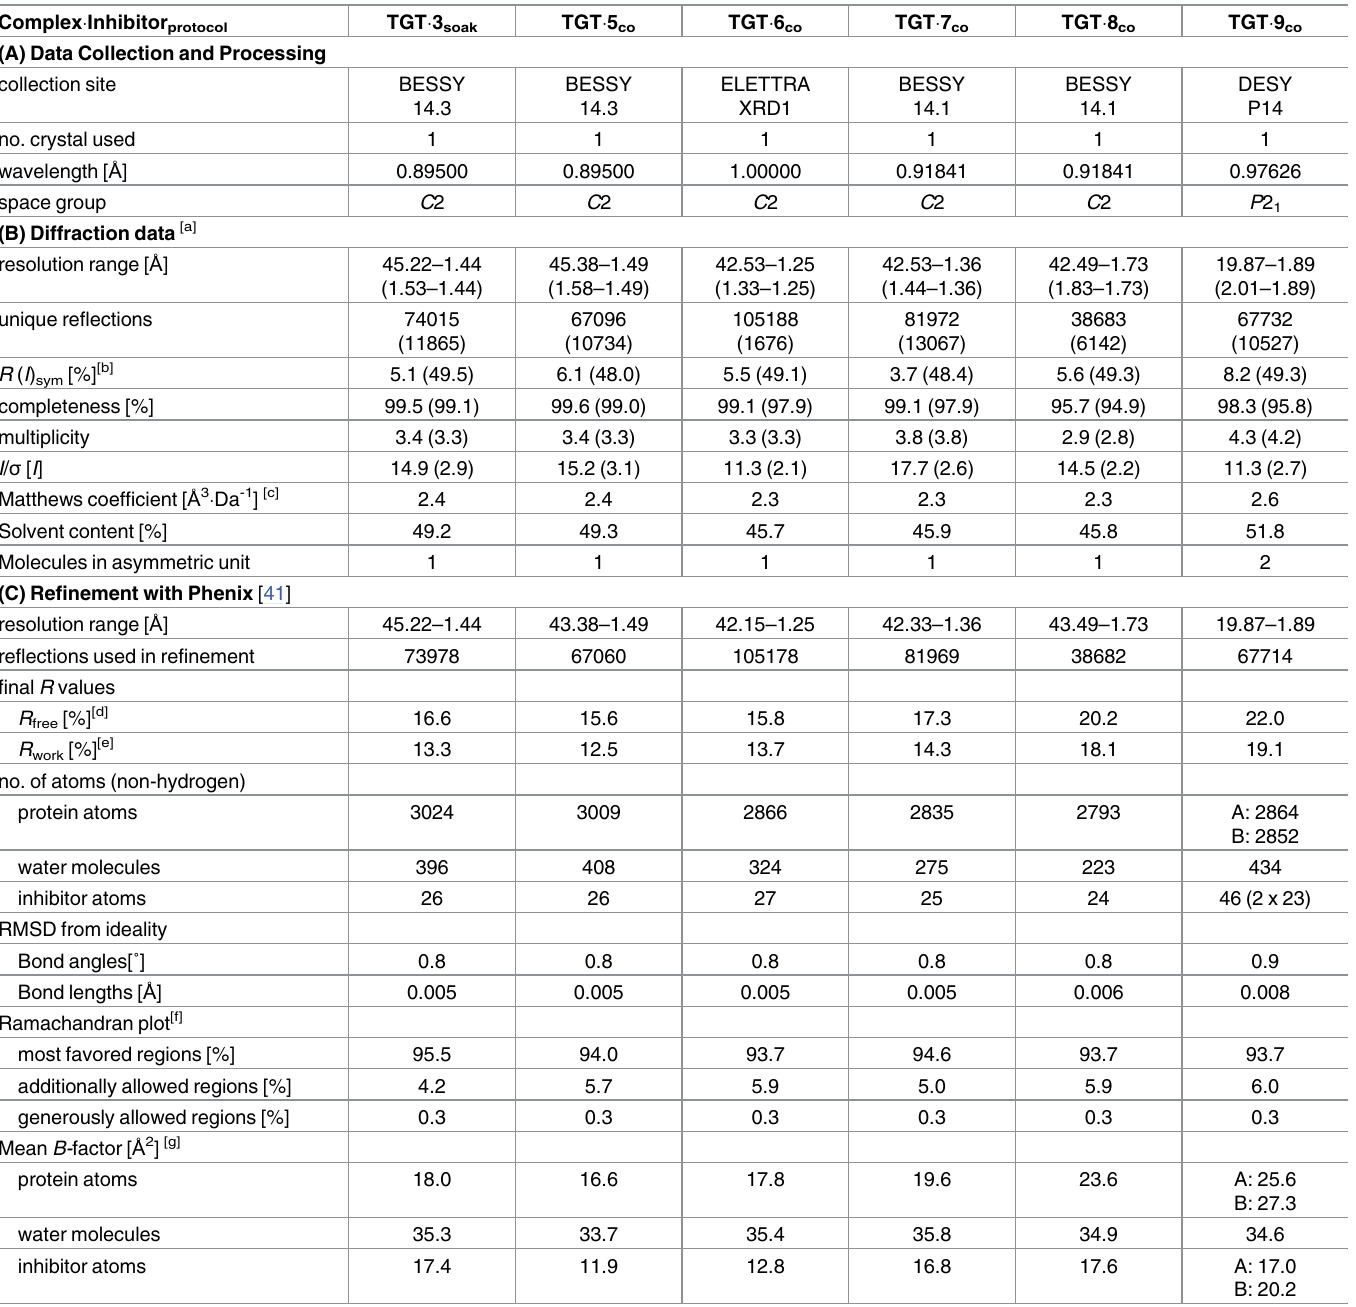
Table 1. Data collection and refinement statistics of X-ray